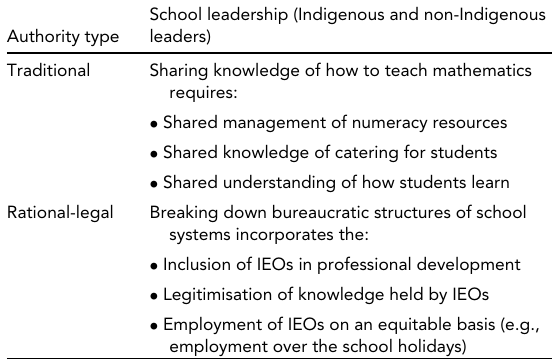
Dimensions That Assist the Transition Within the Classroom Context Authority